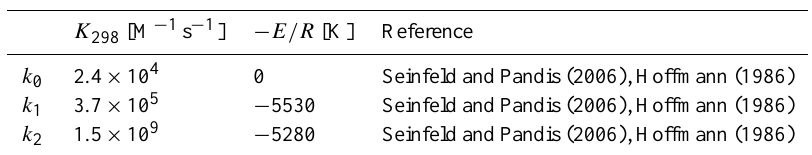
Table 3. Rate constants for the aqueous phase oxidation of S(IV) with dissolved ozone, used in Eq. (11). The temperature dependence of the rate constants is given by k(T ) = k 298 (1977), based on measurements at 16 and 25 ◦ C.